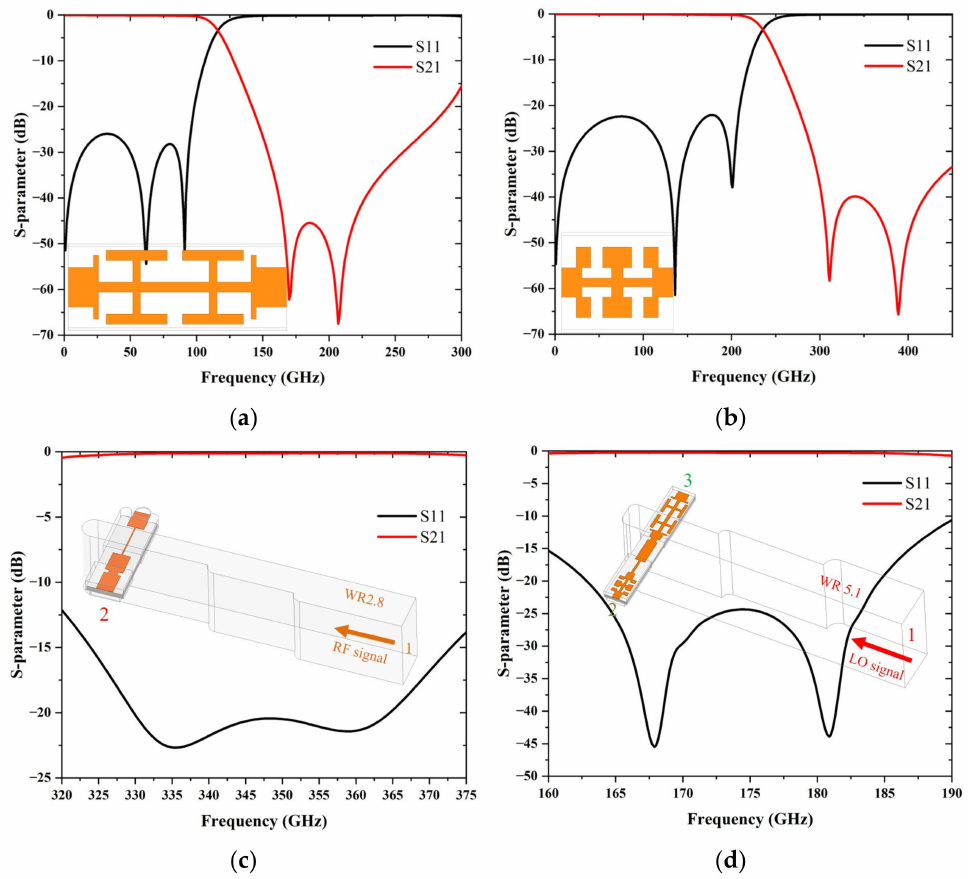
Figure 5. Models of CSMRs filter, hammer-head filter, RF transition, and LO-IF diplexer and their simulated results. ( a ) Simulated results of CSMRs filter; ( b ) Simulated results of hammer-head filter; ( c ) Simulated results of RF transition model; ( d ) Simulated results of LO-IF diplexer